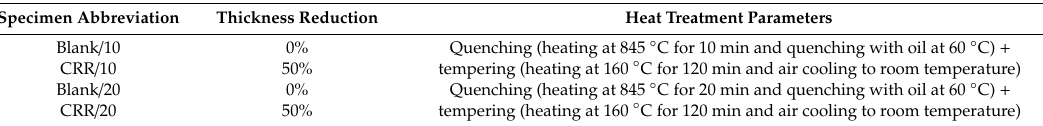
Table 2. Treatment